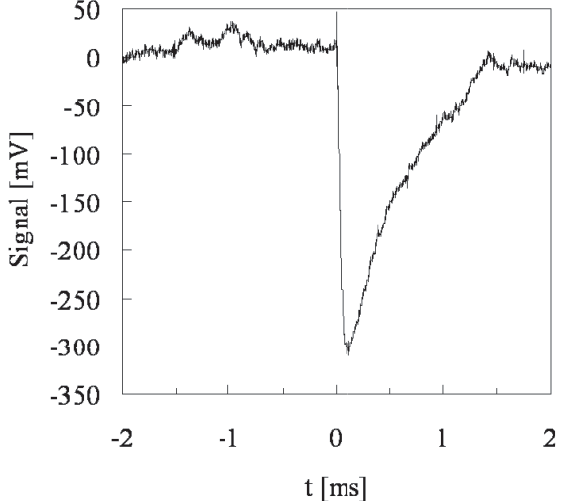
FIG. 5. Optimal signal form detected by the bolometer with a spectral low-pass filter of (cid:4) > 100 (cid:3) m . Its gap at t (cid:1) 0 is proportional to the number of photons detected.